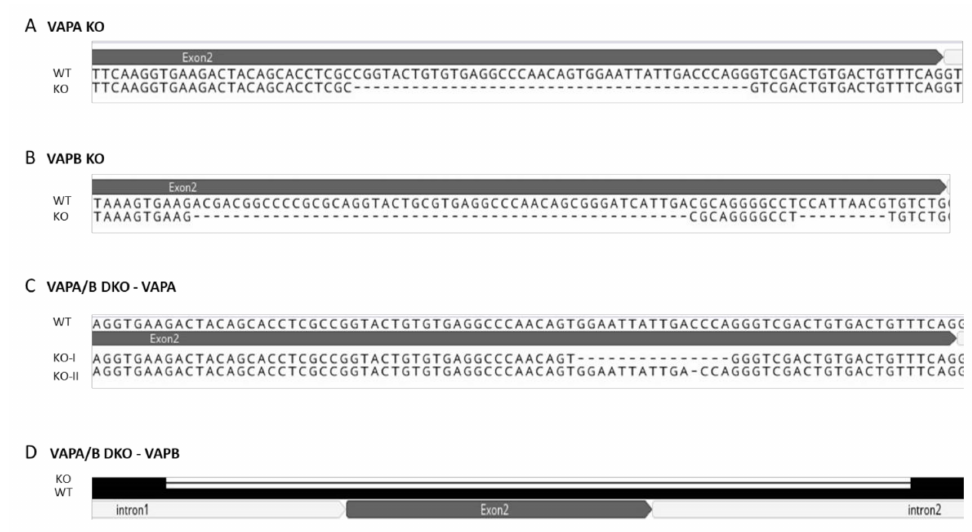
Figure 1. CRISPR/Cas9 genome editing of VAPA- and VAPB-encoding genes in RK13 cells. Shown are the wildtype sequences (WT) and the deletions uncovered in the respective genes of the selected knockout cells (KO). In RK13-VAPA KO cells, 41 nt were deleted in the VAPA ORF ( A ), while 50 nt and additional 9 nt were removed in the VAPB coding region in RK13-VAPB KO ( B ). In both single KO cell lines, the alleles comprise identical changes. VAPA in RK13-VAPA/B double knockout (DKO) contained deletions of 15 nt (KO-I) or 1 nt (KO-II) ( C ), while the complete exon 2 in VAPB is missing ( D ). Due to the large deletion identical regions are indicated by black bars and the deleted sequence is represented by a thin